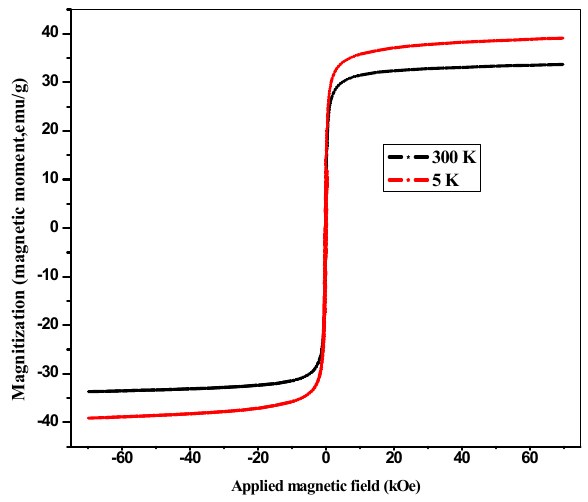
Applied magnetic field (kOe) Figure 6. VSM analysis of the GA/MNPs. Figure 6. VSM analysis of the